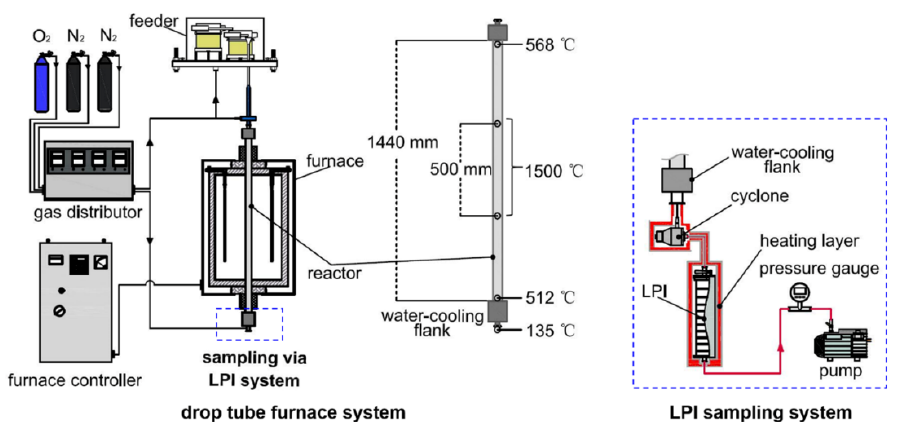
Figure 1. Sketch of the drop tube furnace system and particulate matter (PM) sampling system.